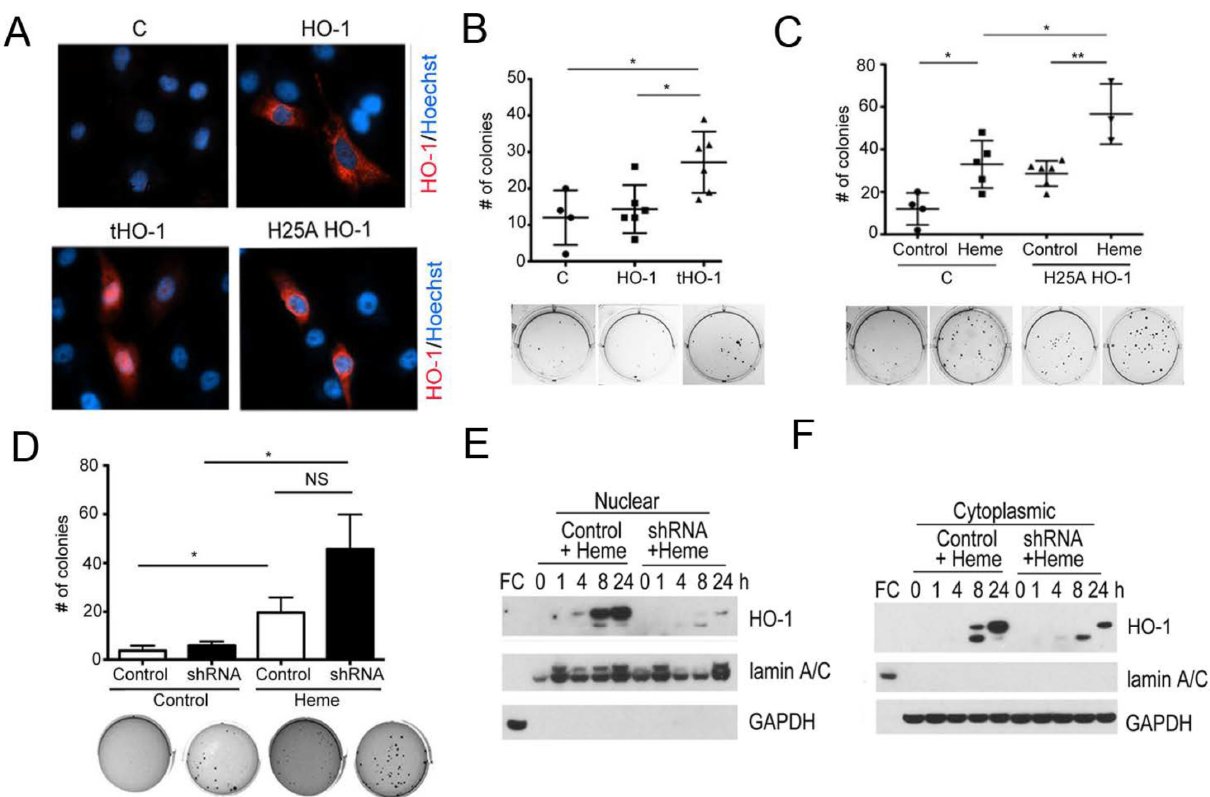
Figure 2. Nuclear HO-1 accelerates growth of PC3 cells. ( A ) Immunofluorescence analyses of PC3 cells overexpressing the Figure 1. the C-terminal 23 amino acid truncated (tHO-1), or the enzymatically inactive (H25A HO-1) HO-1. The C-terminal truncated tHO-1 localizes in the nucleus (bottom-left panel), while the full length (HO-1) and the enzymatically inactive H25A HO-1 localize in the cytoplasm of PC3 cells (top-right and bottom-right panel, respectively) compared to non-transfected cells (top-left panel). ( B,C ) Anchorage-independent growth in soft agar of PC3 cells overexpressing HO-1, tHO-1 or H25A HO-1 with or without heme treatment (50 μ M) for 3 weeks. n = 3 independent experiments in triplicates. * p < 0.05, ** p < 0.01. ( D – F ). PC3 cells with knockdown of HO-1 (shRNA) or transfected with scramble shRNA (control) were treated with heme (50 μ M) for 3 weeks and the number of colonies growing in soft agar was measured. Immunoblotting confirming the knockdown of HO-1 in the PC3 is shown in ( E , F ). The materials and methods part is stated in Supplementary Materials.